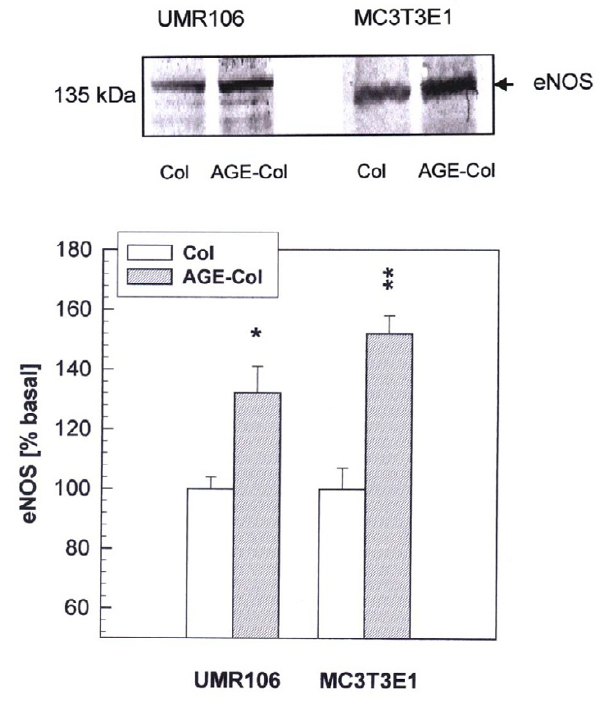
Figure 7 Effect of AGE-modified type I collagen on the expression of eNOS in osteoblast-like cells. UMR106 and MC3T3E1 cells were cultured on control or AGE-modified type I collagen matrices at 37ºC for 24 hours. After this incubation, cell monolayers were lysated in Laemmli's buffer and electro- phoresed under reducing conditions on an 8 % SDS-PAGE. Western blotting was performed, and specific bands were detected using a rabbit polyclonal antibody against eNOS. A representative blot from three independent experiments is presented (top figure). Images were scanned and analyzed by densitometry. The relative intensity of each band is shown (bottom figure) as a percentage of the corresponding basal condition (unmodified collagen), and represents the mean ± SEM. Differences between collagen vs. AGE-collagen are as follows: * p<0.02; **